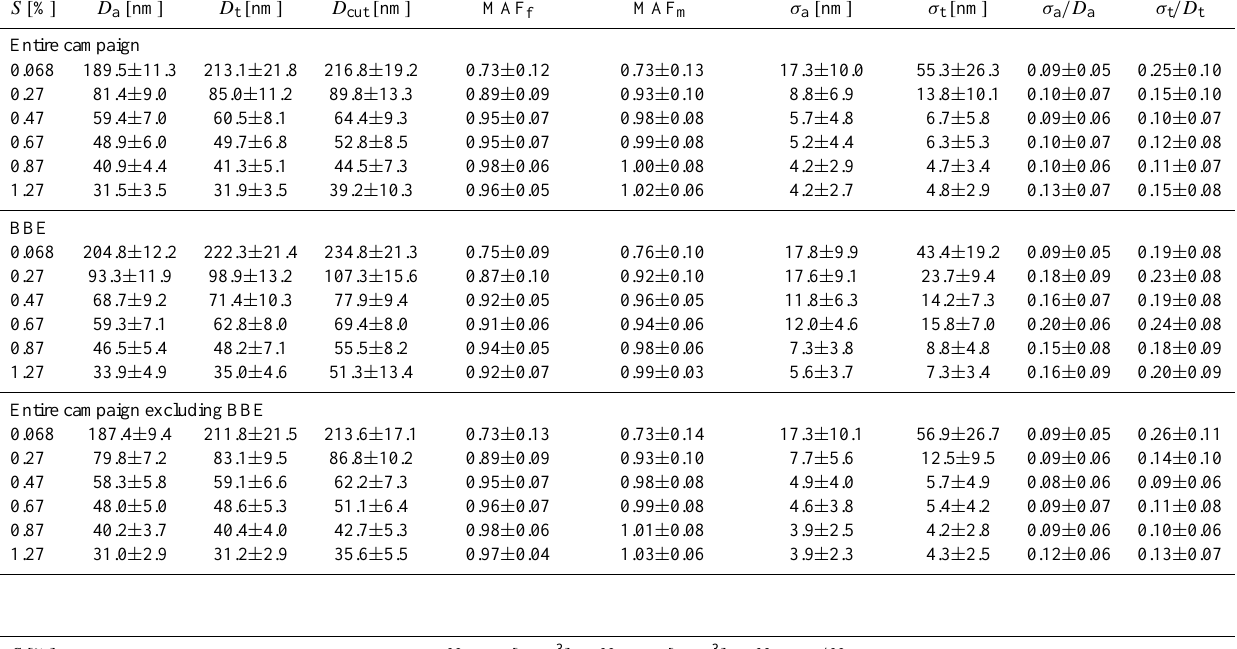
Table 2. Characteristic average CCN parameters (arithmetic mean values ± standard deviation) for the entire campaign, for the Biomass Burning Event (BBE, 23–26 July) and for the campaign excluding the BBE for different S . Quantities are midpoint activation diameters ( D a , D t , D cut ), maximum activated fractions (MAF f , MAF m ), CDF standard deviations ( σ a , σ t ), heterogeneity parameters ( σ a / D a , σ t / D t ), hygroscopicity parameters ( κ a , κ t , κ cut ), number concentrations of total aerosol particles (3–900nm, N CN , tot ) and of cloud condensation nuclei ( N CCN , S ) , and ratio of N CN , tot to N CCN , S as defined in Sect. 2.2.4. n ES and n SD are the numbers of averaged CCN efficiency spectra and size distributions,